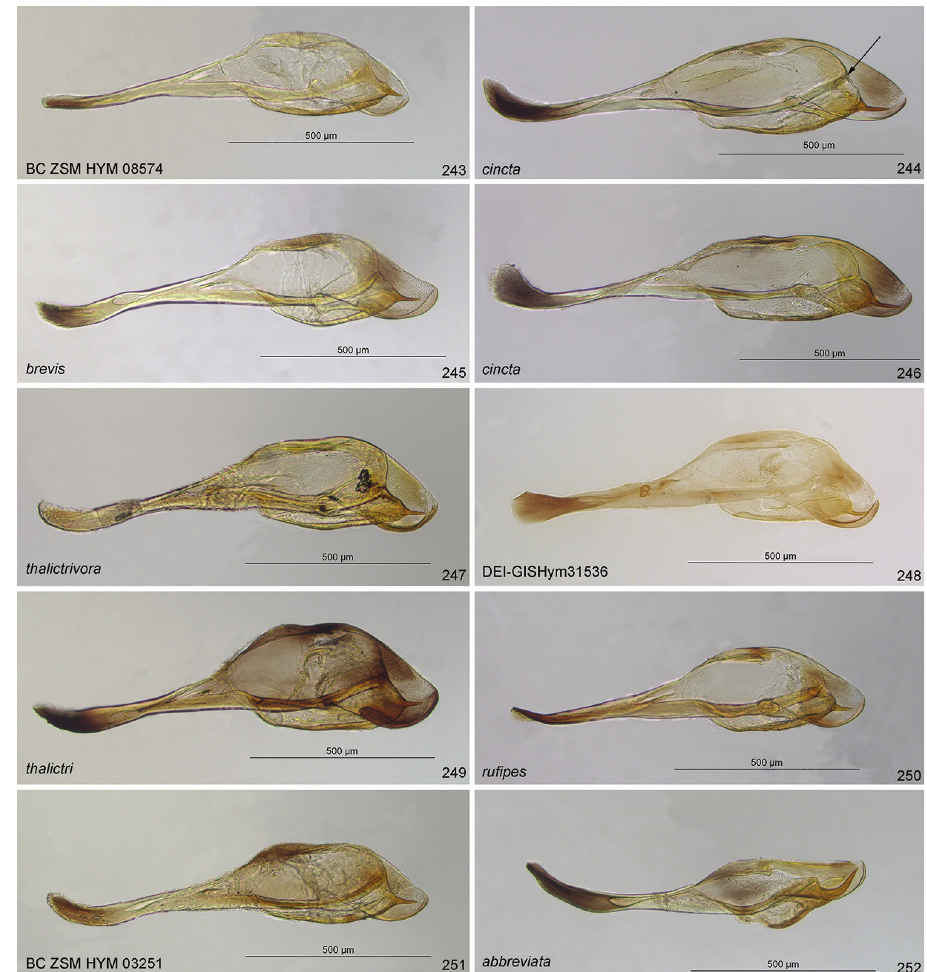
Figures 243–252. Penis valves of Pristiphora . 243 rufipes group (BC ZSM HYM 08574) 244 cincta DEI-GISHym80174 (arrow indicates clearly visible valvar strut at anterior margin of paravalva) 245 bre- vis DEI-GISHym20987 246 cincta DEI-GISHym80158 247 thalictrivora DEI-GISHym20908, para- type of thalictricola , reared from Thalictrum simplex 248 rufipes group (DEI-GISHym31536) 249 thal- ictri DEI-GISHym11428 250 rufipes DEI-GISHym15263 251 rufipes group (BC ZSM HYM 03251) 252 abbreviata